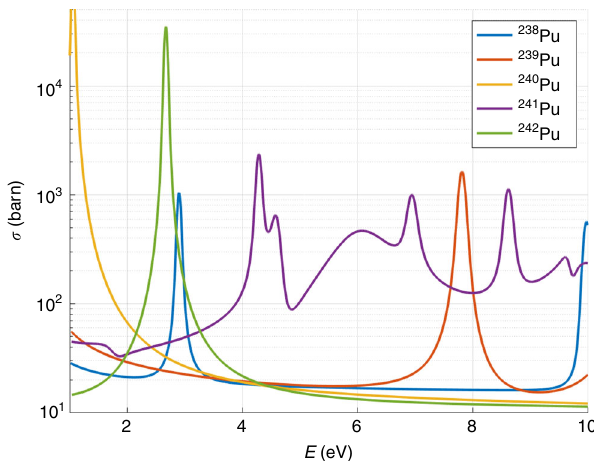
Fig. 1 Epithermal neutron interaction cross sections for plutonium isotopes. The legend lists the fi ve isotopes of interest. For reference, WGPu is almost entirely made out of 239 Pu and 240 Pu, while RGPu contains signi fi cant contributions from 240,241,242,238 Pu. Evaluated data taken from the JEFF-3.2